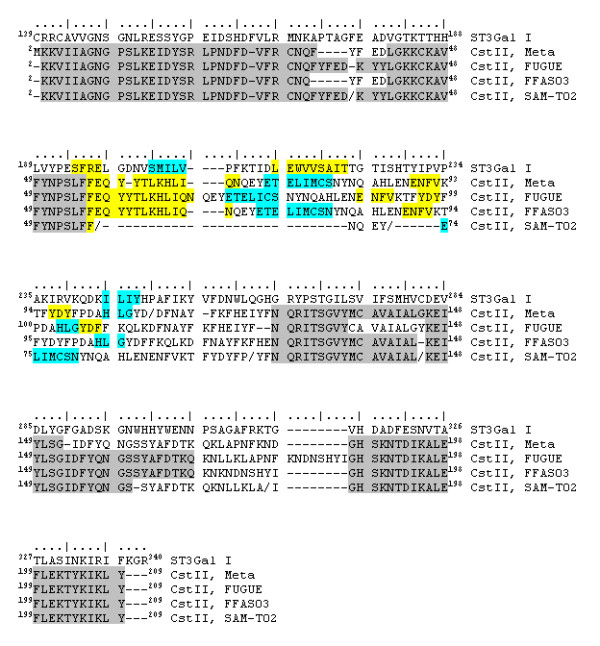
Target (ST3Gal I) – template (CstII, PDB id 1RO7) sequence alignment generated by the fold-recognition servers. The alignments were generated by the indicated servers when ST3Gal I sequence from the L-motif region till the C-terminus was used as query. Regions of alignment that are same for the four servers are highlighted. The alignments for the region spanning residues 215 to 254 of ST3Gal I generated by the four servers are different. The mismatch in alignment of secondary structures of target -- template are also seen in these regions. The helices are highlighted as yellow and the strands are shown in blue (as in Figure 1). Such a disagreement for this region is seen in the case of other ST3Gals also.